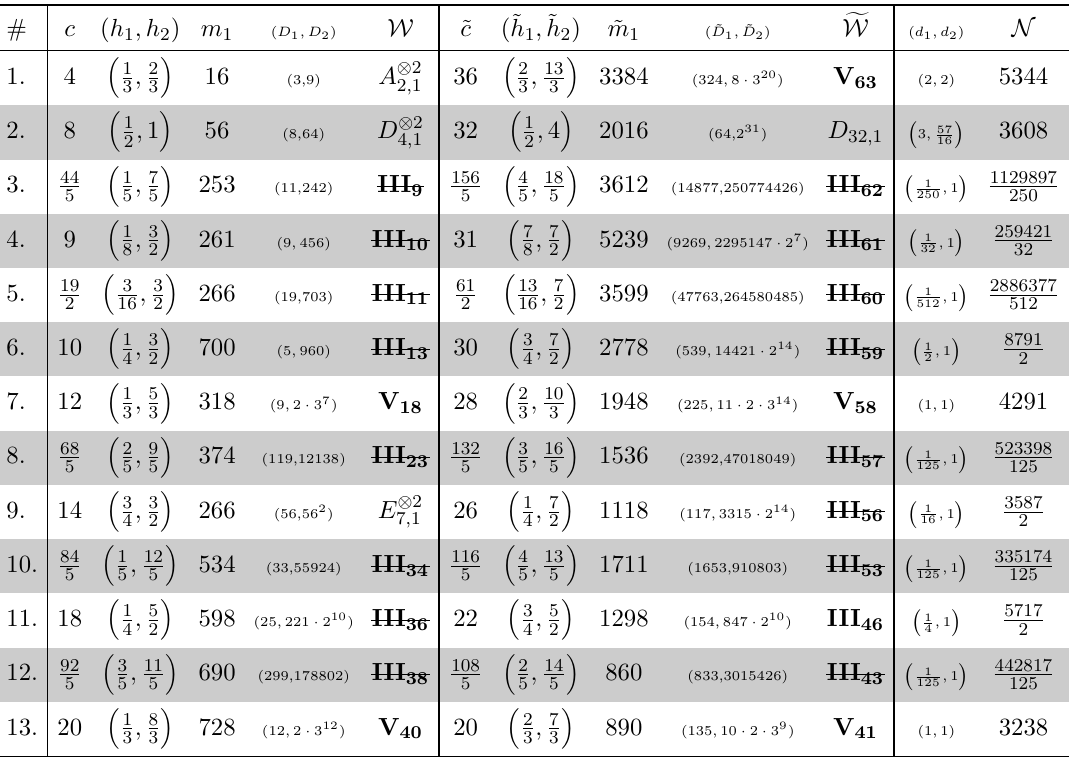
Table 18. Inconsistent pairings, c H = 40 with ( n 1 , n 2 ) = (1 , 5)